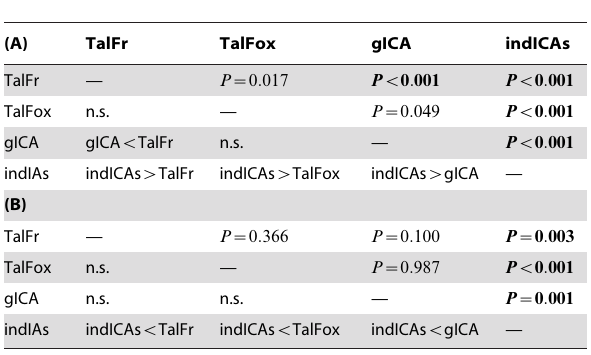
(A) Marginal correlation. (B) Absolute change in marginal correlation. Upper triangular matrix: significance level of a pairwise effect of method. Significant P -values at a threshold of p ~ 0 : 05 corrected are emphasized in bold. Lower triangular matrix: direction of effect; n.s.: nonsignificant. Note that, since changes are usually negative, a larger change means a change that is smaller in amplitude.